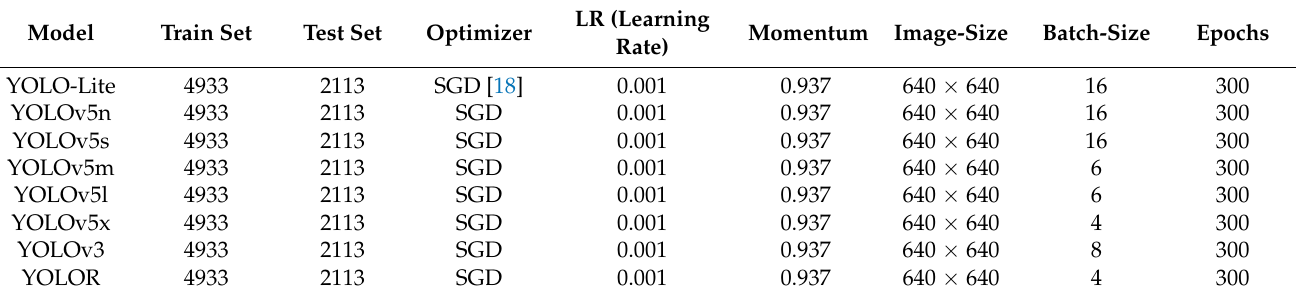
Table 2. The detailed training strategies of underlying